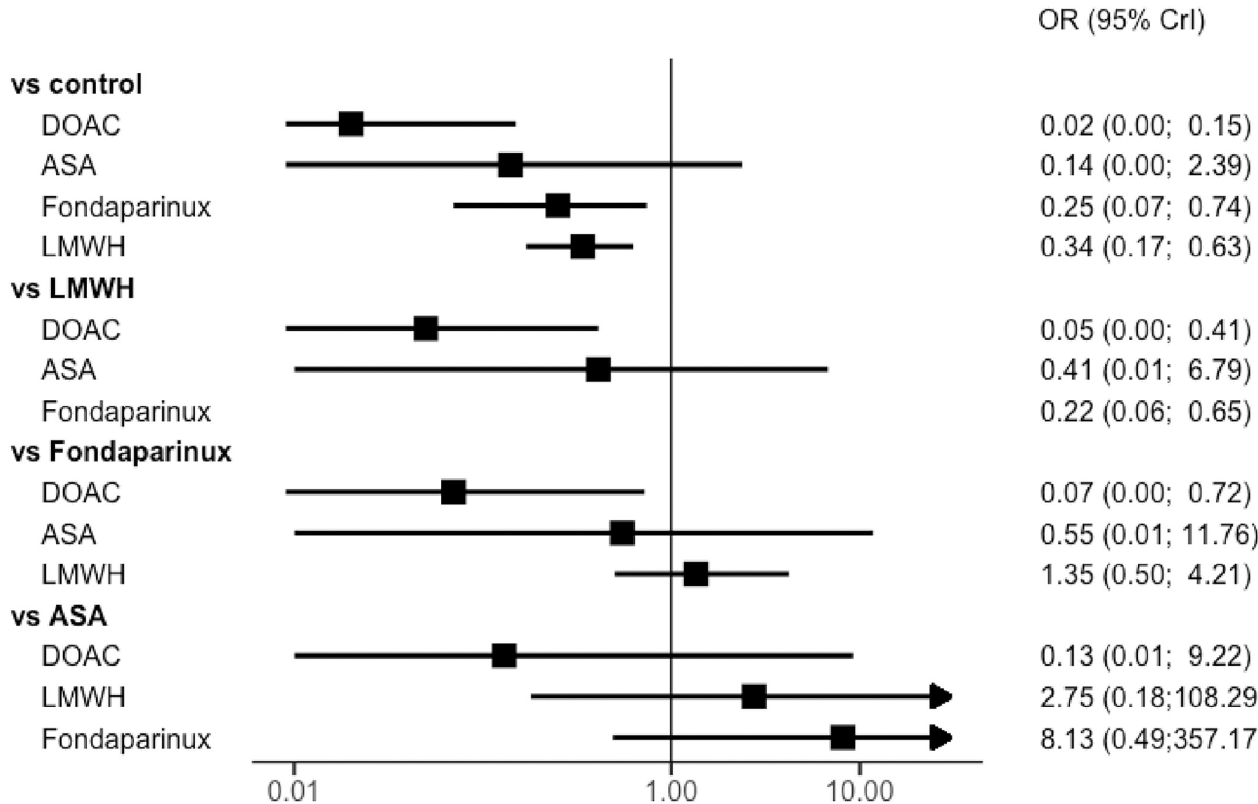
Fig 6. Network forest plot for the secondary outcome (net clinical benefit: major VTE and major bleeding) in all RCTs with OR (points) and their 95% CrIs (lines). ASA, aspirin; DOAC, direct oral anticoagulant; LMWH, low molecular weight heparin; OR, odds ratio; RCT, randomized controlled trial; VTE, venous thromboembolism; 95% CrI, 95% credible